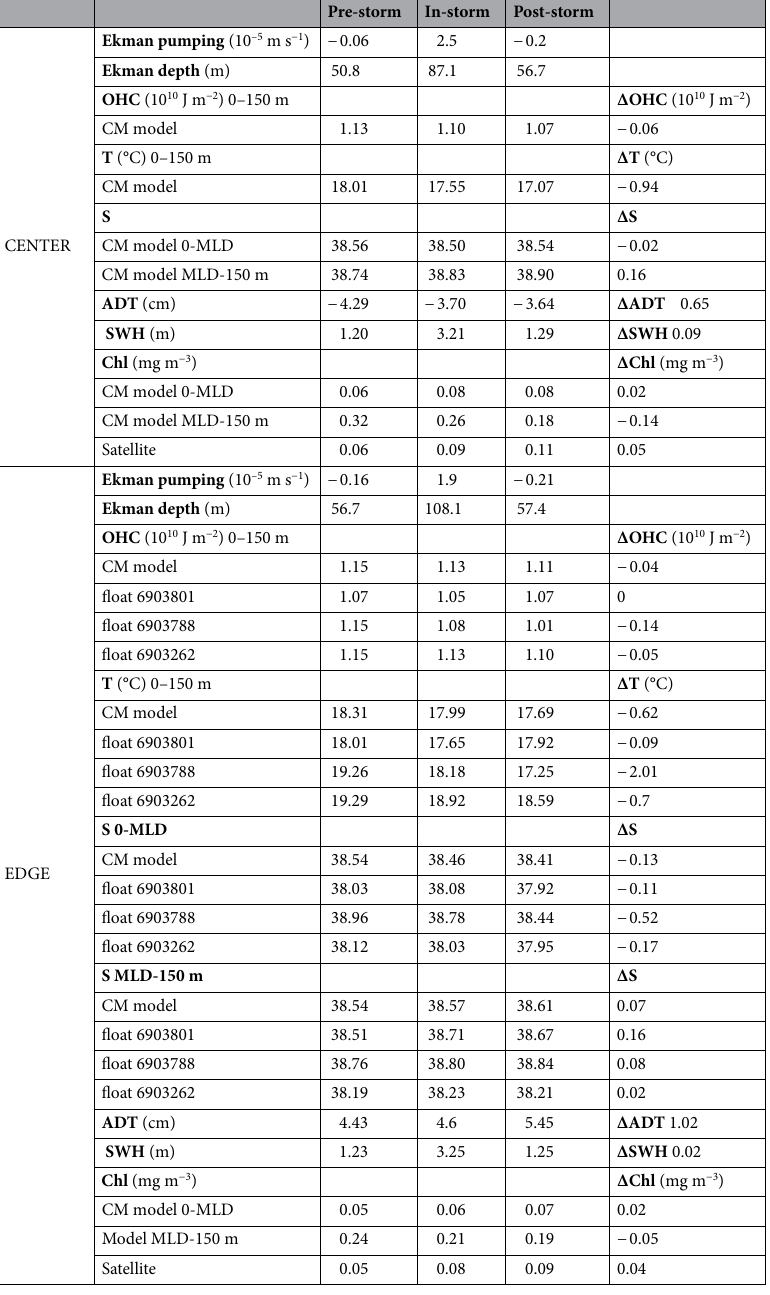
Table 1. Mean distribution of the Ekman pumping, Ekman depth, Ocean Heat Content (OHC), temperature (T), salinity (S), Absolute Dynamic Topography (ADT), Significant Wave Heigh (SWH), and chlorophyll-a (Chl) in the Center and in the Edge sectors of the ocean area impacted by the Medicane Apollo, during the Pre-storm, In-storm, Post-storm time periods. The last column shows the difference between the Post-storm and Pre-storm conditions for each parameter (∆). Mean values of OHC, T, and S defined by the CM model in the Edge sector are compared with those obtained from the floats located in the same sector. Mean values of Chl in the surface layer are compared with that obtained from the satellite in the Center and Edge